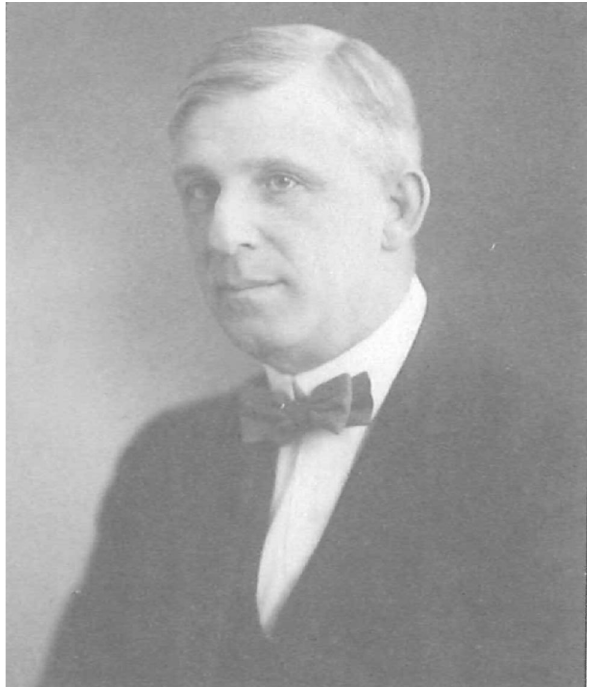
Figure 1. N. Gist Gee in 1933.